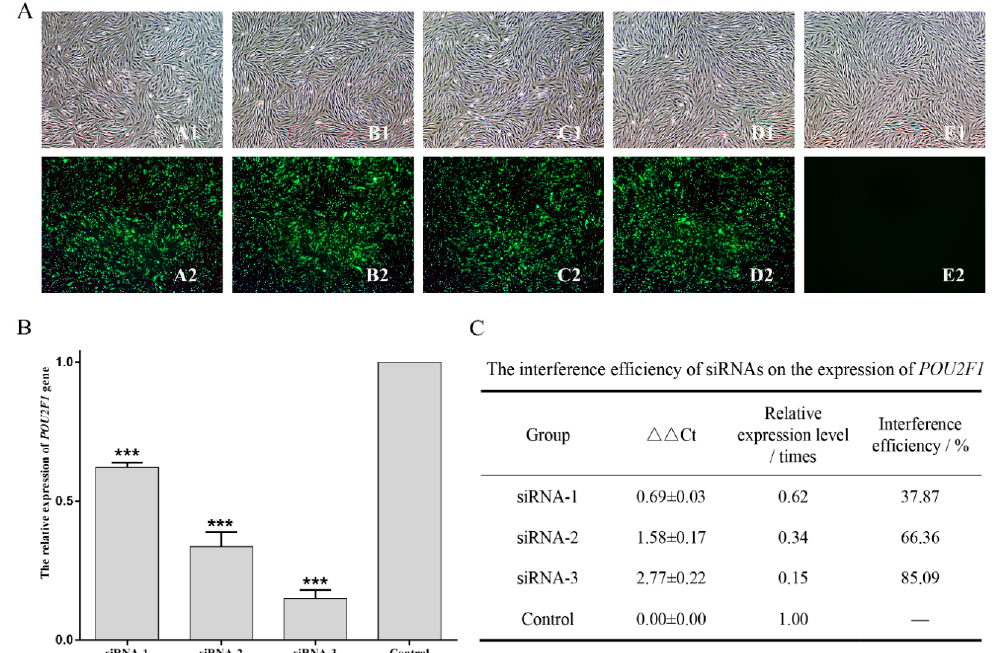
Figure 4. Interference efficiency of siRNAs on POU2F1 expression. ( A ) Melanocyte morphology 24 h after FAM-siRNAs transfection. A – E represent siRNA-1, siRNA-2, siRNA-3, NC, and blank,